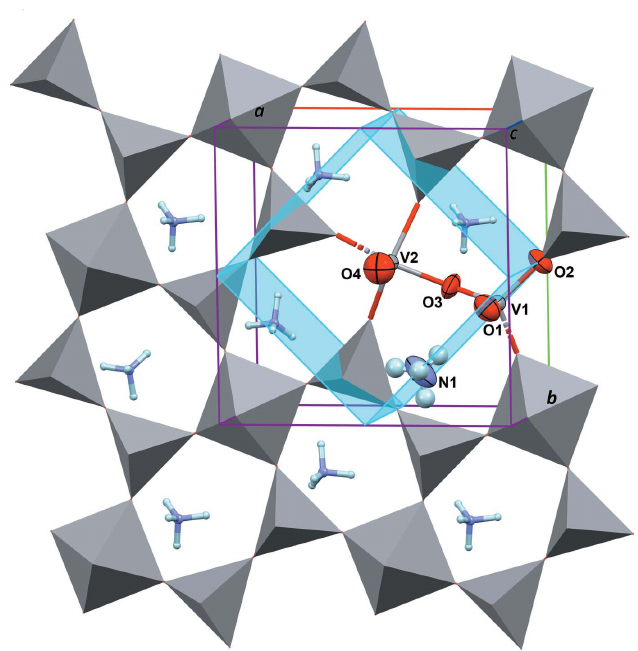
Figure 1 Crystal structure of (NH 4 ) 2 V 3 O 8 viewed approximately down the c axis. The asymmetric unit is represented with displacement ellipsoids drawn at the 90% probability level, and other vanadate groups are drawn with a polyhedral representation. Only one (V 3 O 8 ) 2– layer normal to [001] is represented, and a single position for the disordered NH 4+ cation has been accentuated. Blue planes are the mirror m elements of space-group type P 4 bm .